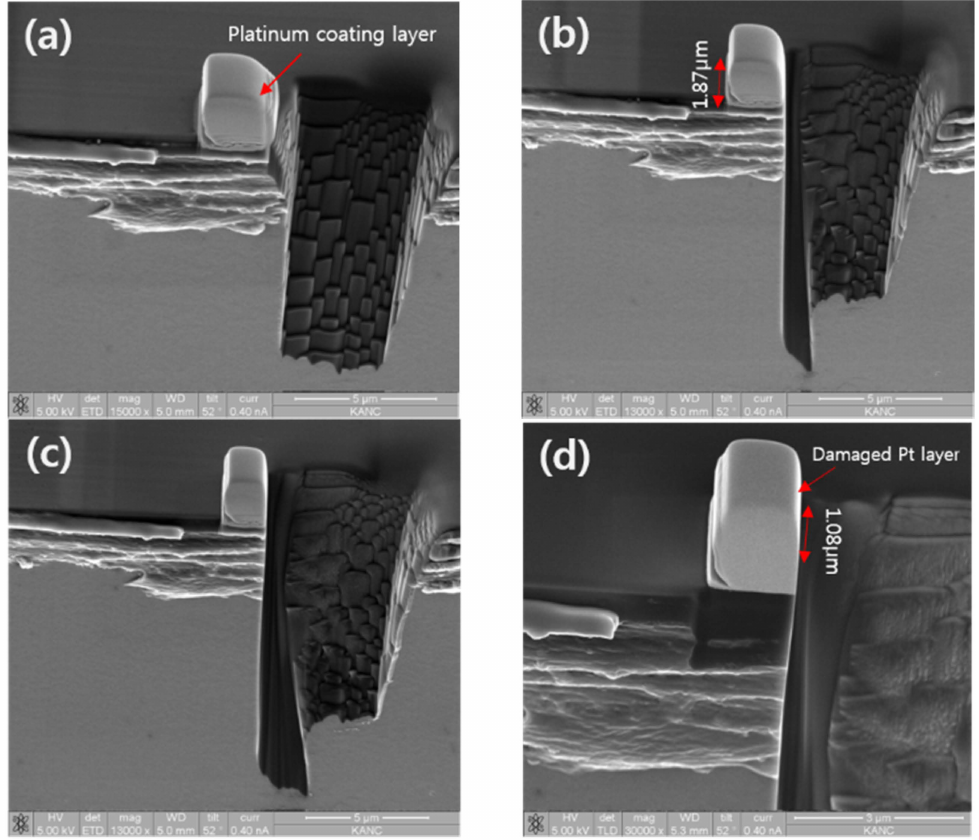
Figure 3. SEM images of ( a ) Rectangle type focused ion beam (FIB) machined diamond (tilt angle: 52 ˘ 4 ˝ , beam current: 7 nA, voltage: 30 kV); ( b ) Cleaning type FIB machined diamond (tilt angle: 52 ˘ 1.5 ˝ , beam current: 1 nA, voltage: 30 kV); ( c ) Cleaning type FIB machined diamond (tilt angle: 52 ˘ 1.5 ˝ , beam current: 100 pA, voltage: 30 kV); ( d ) Cleaning type FIB machined diamond (tilt angle: 52 ˘ 1.5 ˝ , beam current: 50 pA, voltage: 30 kV).